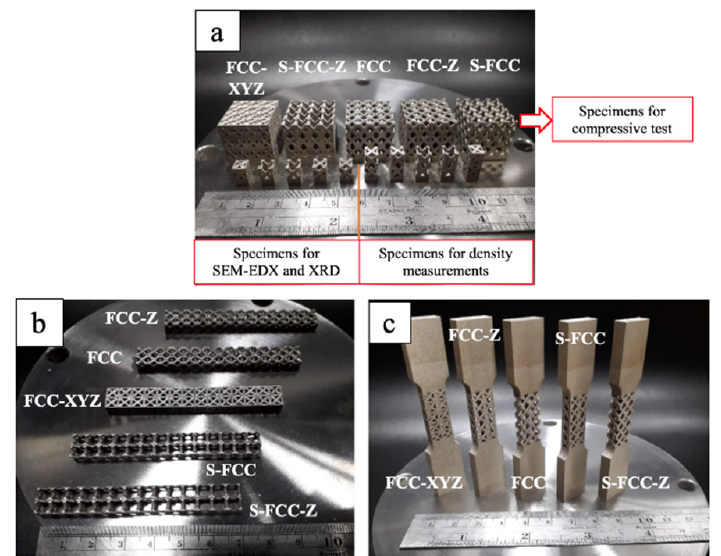
Figure 3. SLM of specimen with five types of lattice structure for ( a ) compression, density, SEM-EDX and XRD tests, ( b ) flexural test and ( c ) tensile test.